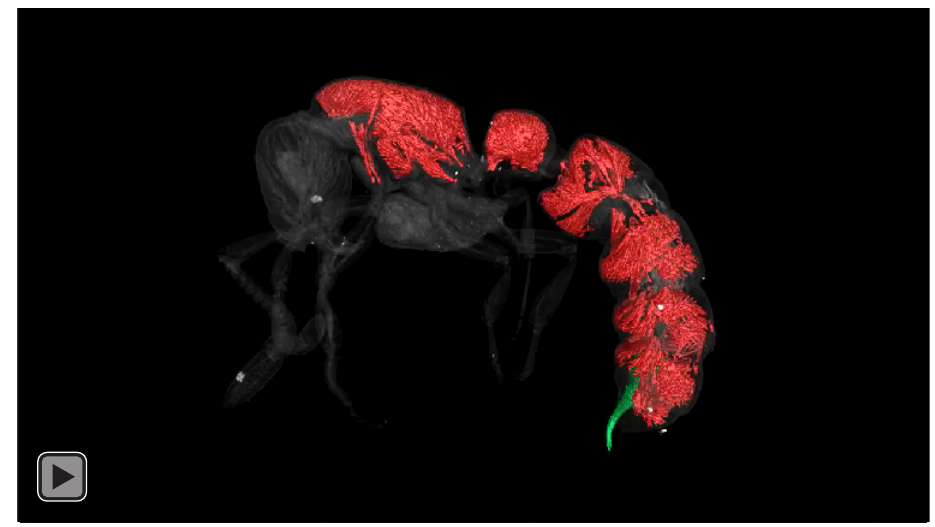
Video 5. 3D rotation video of full body of Zasphinctus sarowiwai sp. n. holotype worker (CASENT0764654). False-colour volume rendering of segmented mesosoma and metasoma musculature (red) and sting apparatus (green) superimposed on semitransparent surface